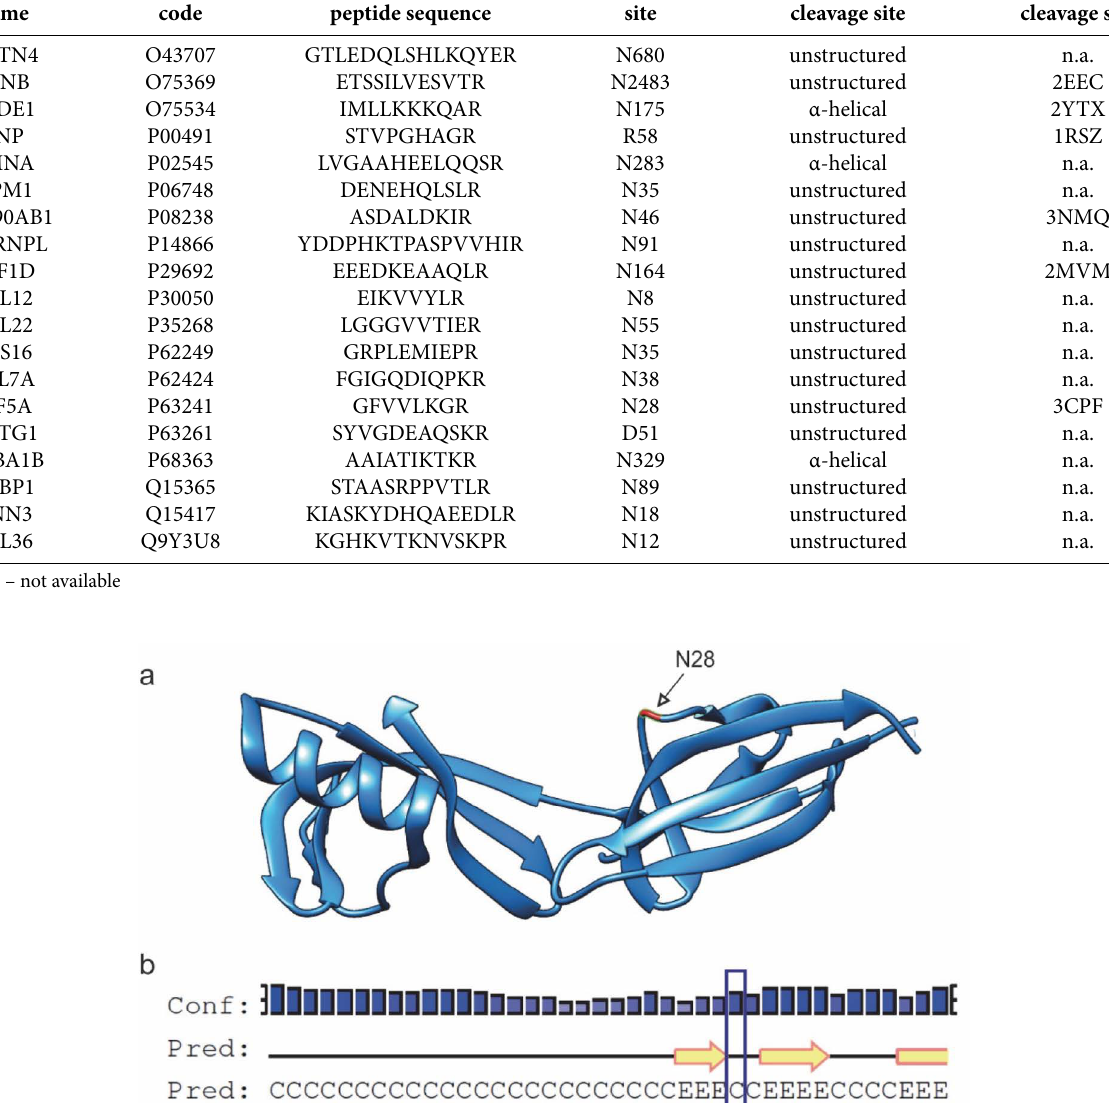
Table 2. Structural determinants of 19 identified legumain cleavage sites determined using disordered regions and secondary structure prediction algorithms. Gene